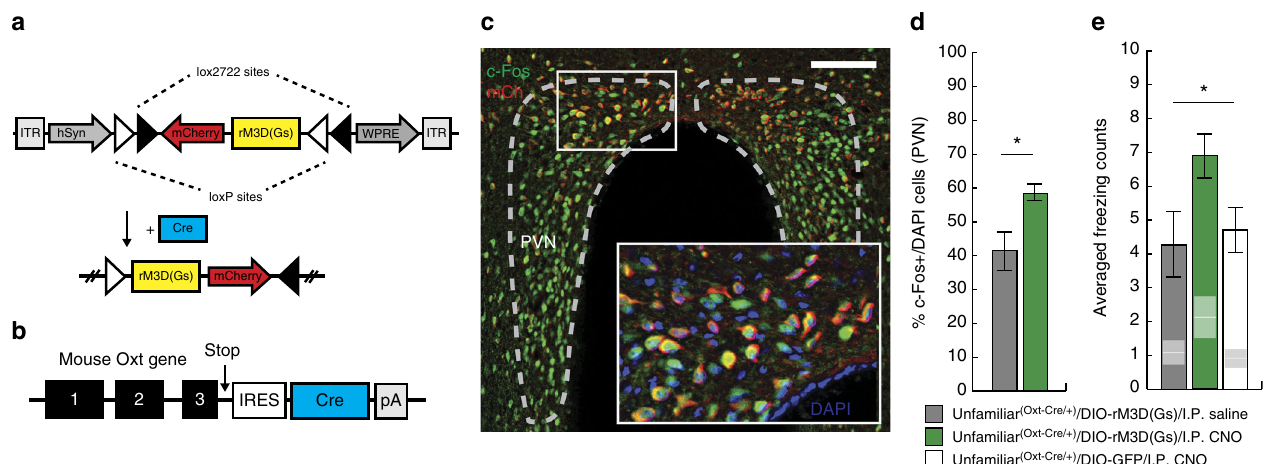
Fig. 4 Chemogenetic activation of oxytocinergic neurons enhances socially transmitted fear in unfamiliar male mice. a Schematic of construct used for viral incorporation of the rM3D(Gs) receptor before and after Cre-dependent recombination. b Schematic of Cre recombinase transgene insertion at the mouse oxytocin gene. c Representative c-fos and mCherry immunoreactivity within the paraventricular nuclei (PVN; dashed outline) expressing rM3D(Gs) receptors (scale bar, 100 μ m) and magni fi ed view of co-labeled c-Fos+/mCherry-expressing neurons. d Quanti fi cation indicating signi fi cantly elevated percentage of c- Fos+/DAPI cells within the PVN of CNO-treated mice (3mg/kg, I.P.; green, n = 4 mice) compared to saline-treated controls (gray, n = 4 mice) expressing the rM3D(Gs) DREADD (two-tailed Student ’ s t- test: t (7) = 2.65, p = 0.050). e Administration of CNO (3mg/kg, I.P.) 30min prior to demonstrator conditioning enhanced freezing in unfamiliar male mice expressing rM3D(Gs) (green, n = 10) compared to saline-treated controls with rM3D(Gs) (gray, n = 9) and CNO- treated controls without rM3D(Gs) (white, n = 10) when averaged over conditioning trials (ANOVA: F 2,28 = 3.41, p = 0.048). White lines and gray boxes within bars indicate mean and s.e.m. of freezing counts, respectively, during acclimation. Black error bars represent s.e.m. * p <